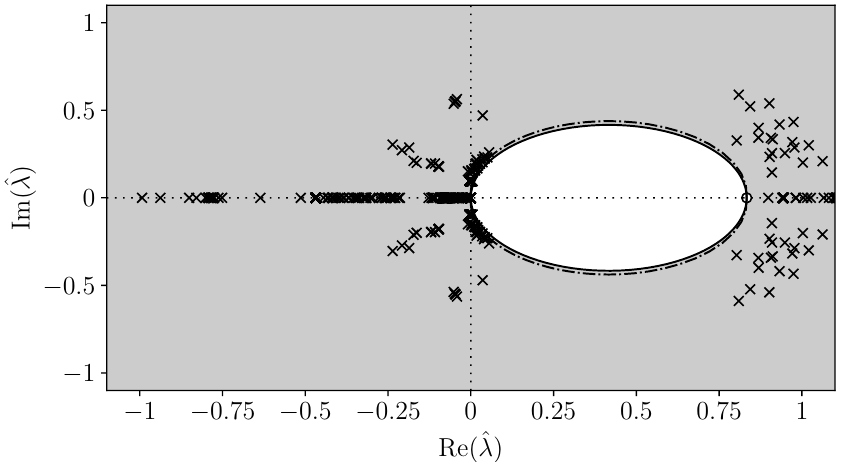
Figure 2. AIITS: shift & invert transform image of the spectrum, σ =